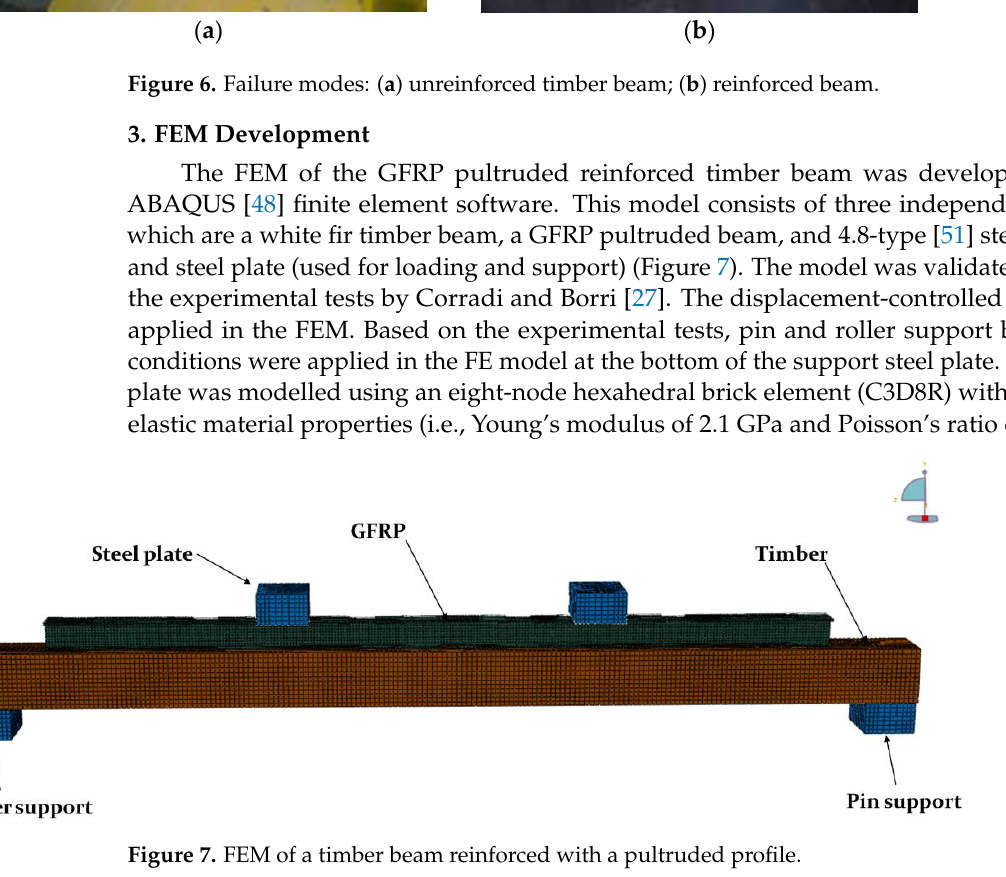
Figure 8. Timber material directions: ( a ) local coordination; ( b ) global coordination. The timber orthotopic elastic properties can be defined by Equation (1) using linear elastic stresses and strains: